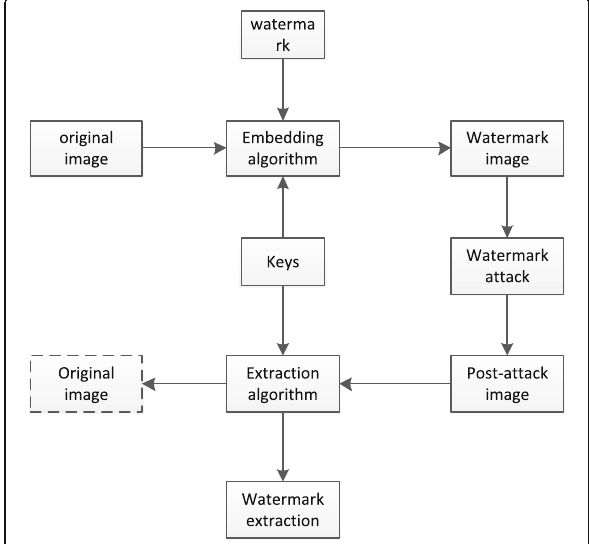
Fig. 5 Image watermarking model Fig. 4 The parity check matrix and bidirectional